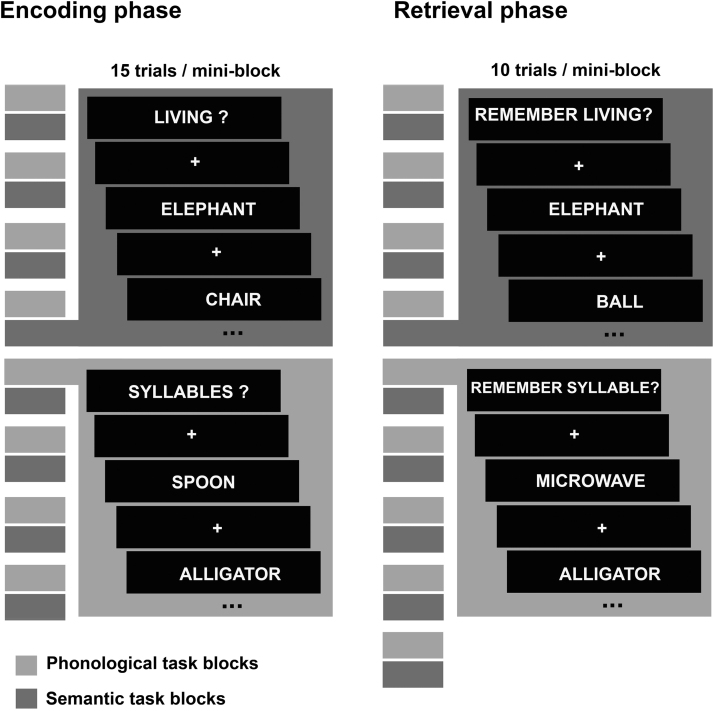
Paradigm design. Illustrates the mini-block structure of the study and test phases of the task. Note that not all mini-blocks are shown. See Experimental design and task for details.